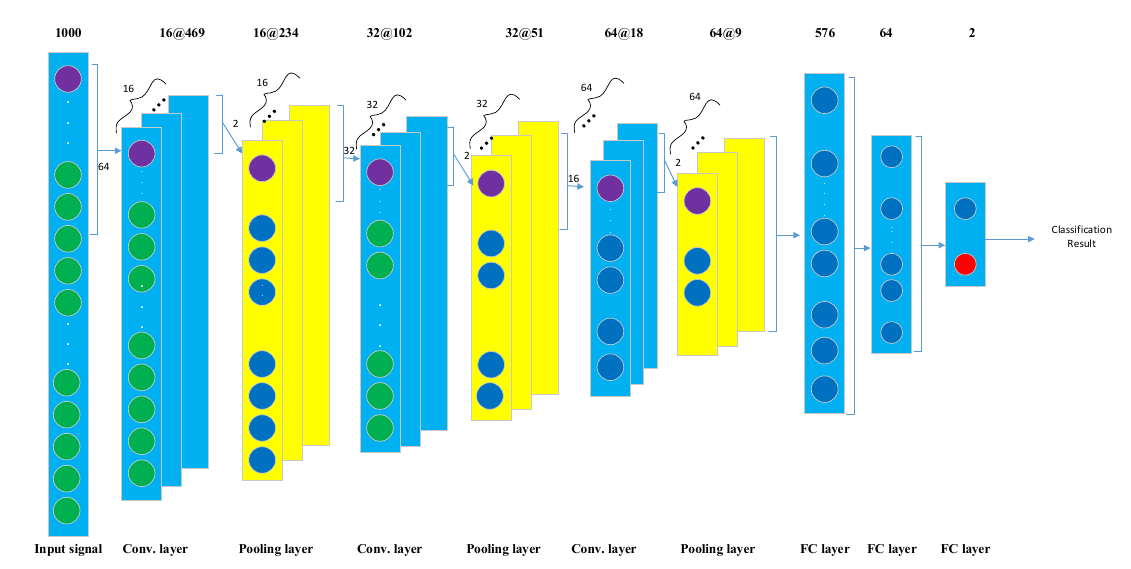
Figure 6. Binary classification with the approach of time-domain signal+1D-CNN.